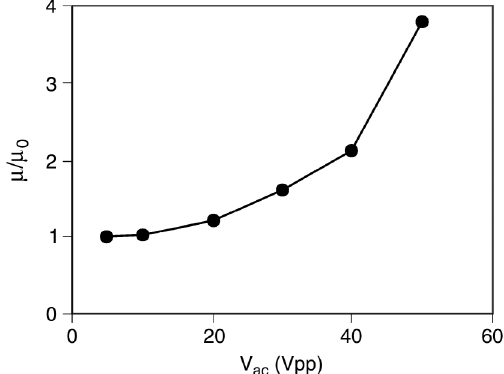
FIG. 3. Electrophoretic mobility values of a single particle with radius 3 : 38 (cid:1) m in dodecane with surfactant concentration ¼ 0 : 001 for different applied ac voltages V (cid:2) m the value (cid:1) 0 at V ac ¼ 5 Vpp . The sinusoidal voltage V ac at frequency f ¼ 21 Hz is applied across the electrodes separated